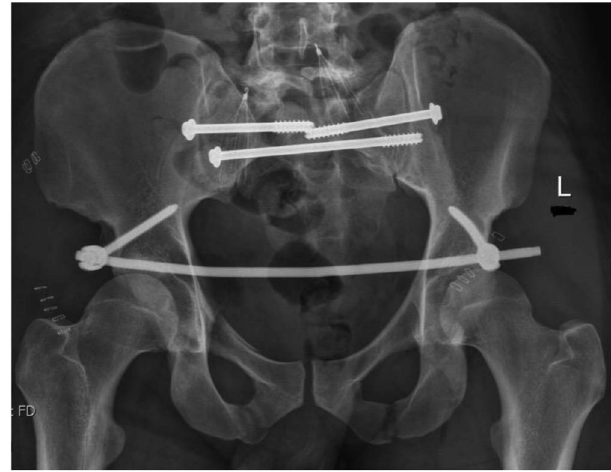
Figure 7. Day 1 after fi xation. Bilateral sacroiliac joint screws with INFIX. Filters in both common iliac veins. AP image.